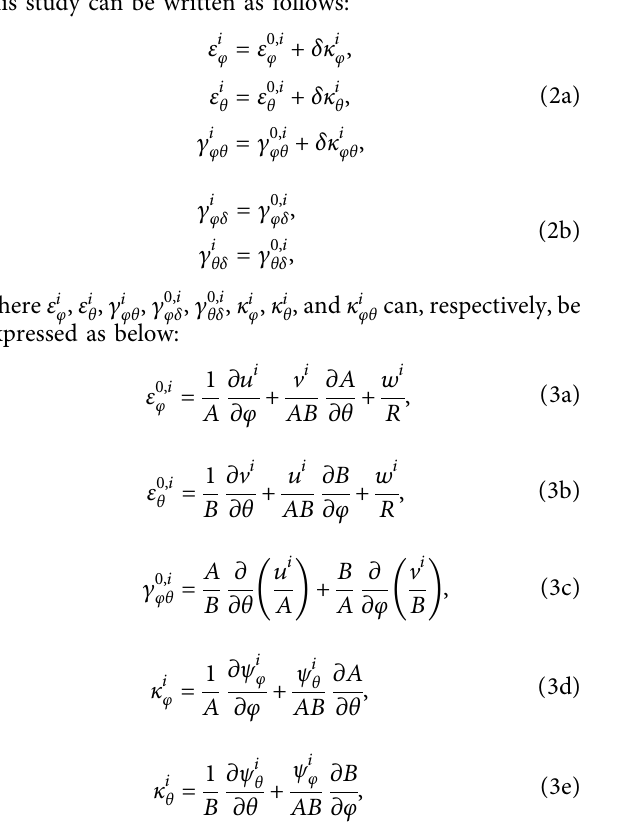
Figure 1. The deformation displacements of the annular spherical shell with respect to the coordinate system can be, respectively, defined by u , v , and w in the φ , θ , and δ di- rections, and the system ( φ , θ , δ ) represent axial, circum- ferential, and normal directions, accordingly. C and h , s respectively, represent the geometry center and thickness of the annular spherical shell. φ and φ , respectively, denote 0 1 the center angle correspond to the top and bottom of an- nular spherical shell. The formulas of this paper are derived on the basis of the domain decomposition method [36–41], the spherical shell is divided into H segments along axial direction, and the artificial springs are arranged at both ends of each segment; the continuity condition and various boundary conditions can be simulated by assigning the stiffness values of